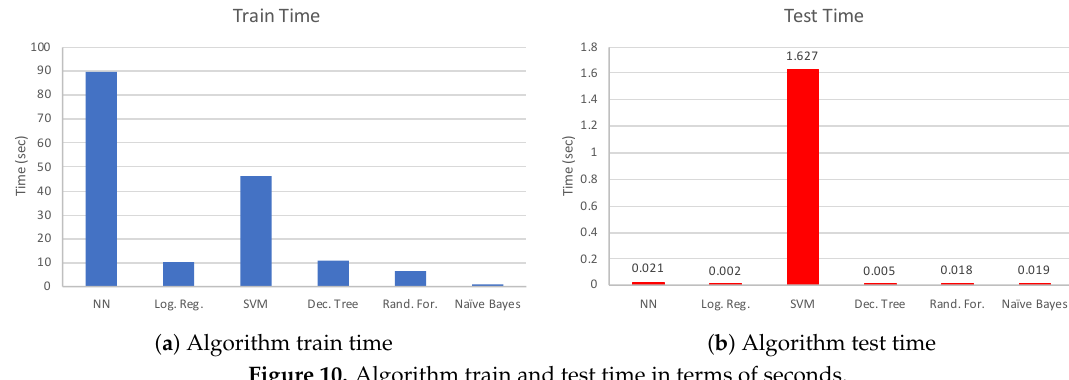
Figure 10. Algorithm train and test time in terms of